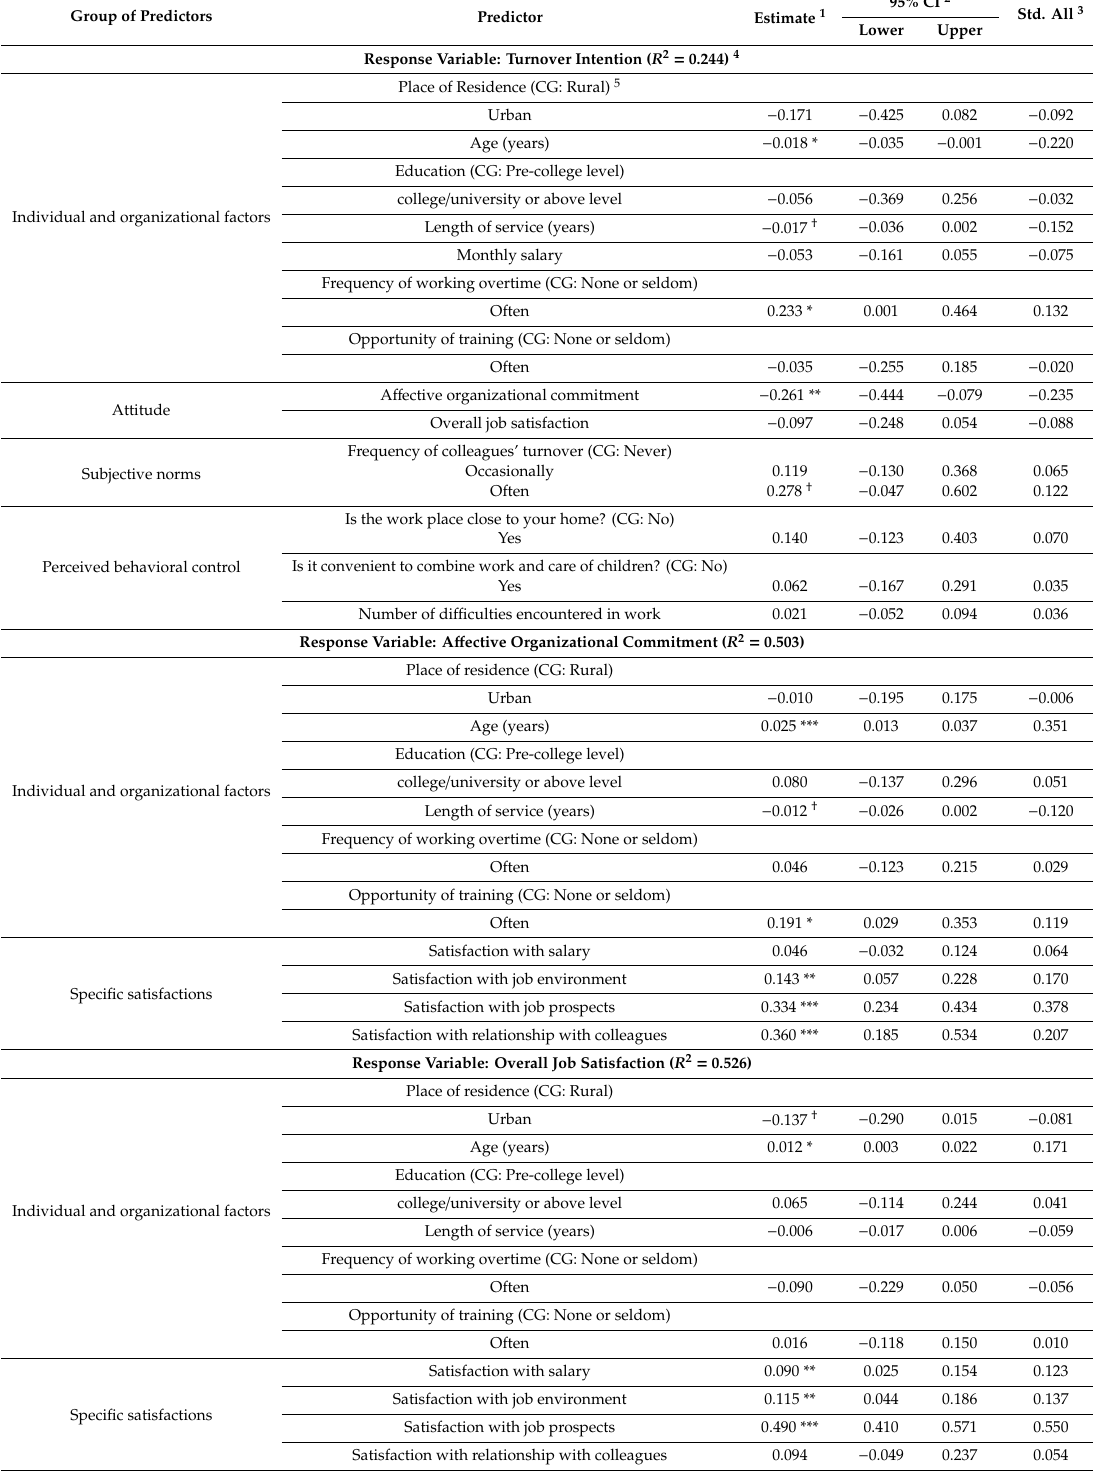
95% CI 2 Std. All 3 Lower Upper